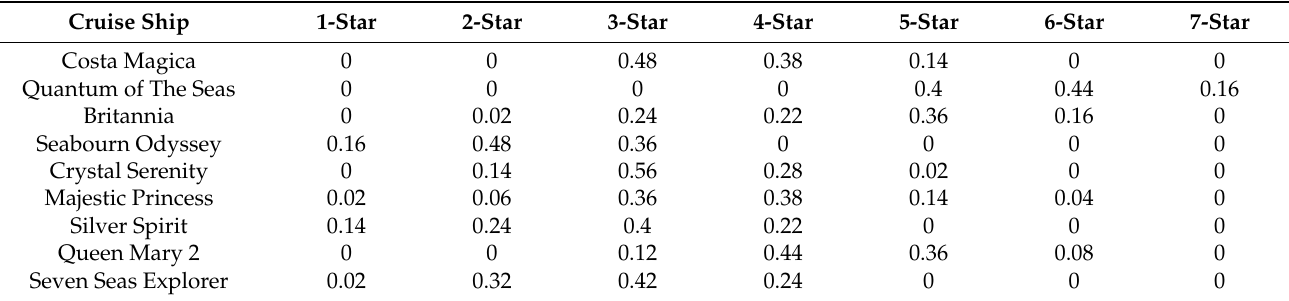
Table 9. Aggregated cruise star rating results from five experts.